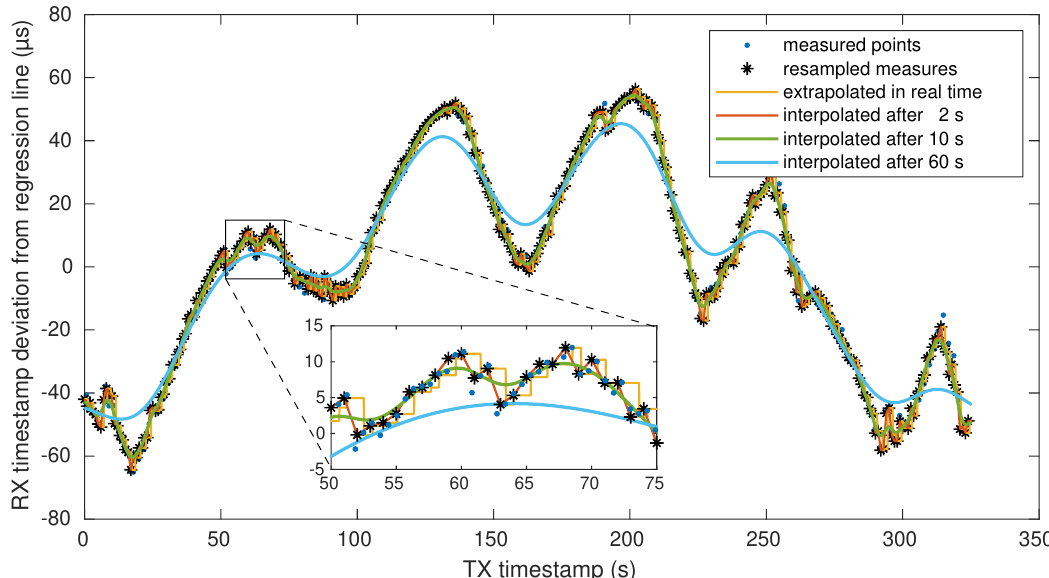
Figure 8. Example of the operation of the smoothing and interpolating filter used to convert the TX-side time scale to that of the receiver (assumed to match real time). Dots represent the measures out of the first-stage double exponential smoother, they are still somewhat noisy at microsecond scale (1/ F S = 1250 µs). Stars are the same measures resampled on a uniform time base using linear interpolation, so they possess the same amount of noise. Curves are the result of the final interpolation to match the sampling frequency F S . Higher latencies allow for longer filter impulse responses and better interpolation/filtering. To make microsecond deviations graphically visible, the vertical axis shows differences between actual values and the ideal regression line computed after all data had been